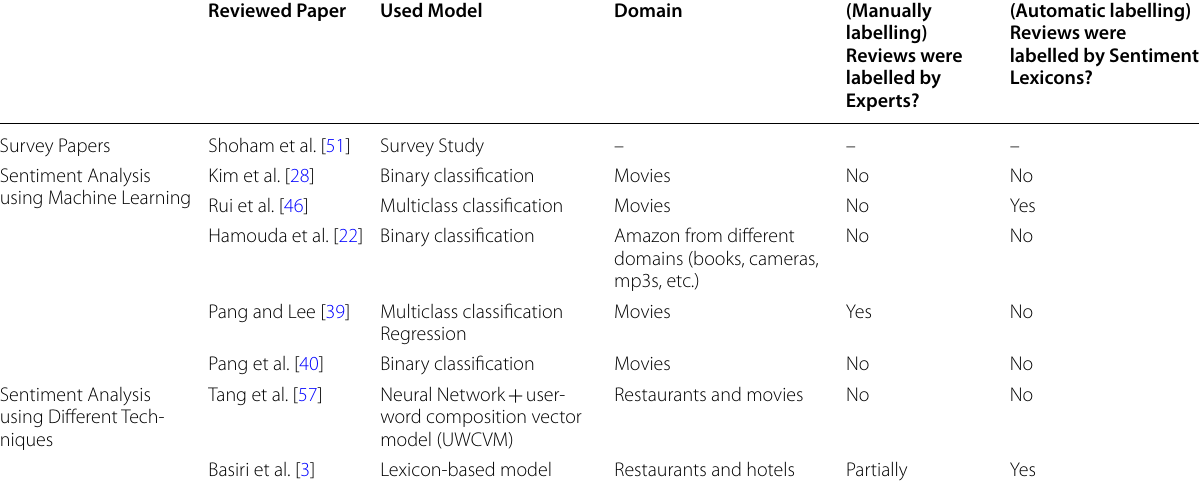
Table 1 Summary of the reviewed papers in which no validation procedure has been applied to examine the relationship between numeric ratings and texts